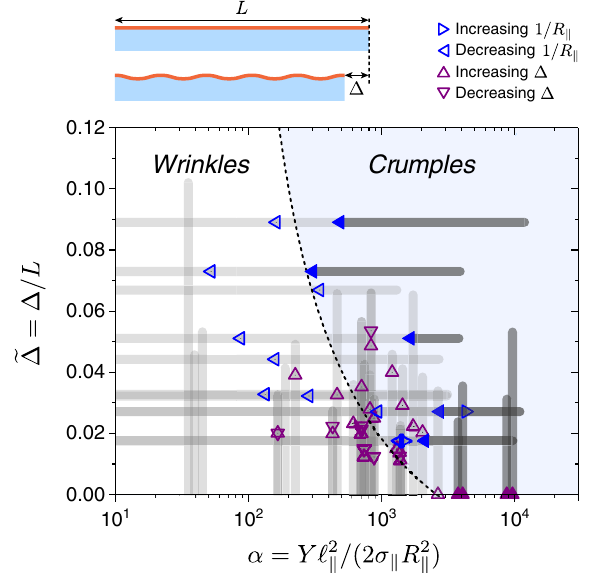
FIG. 7. Role of compression in the crumpling threshold. Symbols show the observed crumpling transition for experiments in the sheet-on-cylinder setup, where either the curvature 1 =R k or the compression Δ are varied while the other is held fixed. The sheet width ( 1 . 6 < W < 3 . 2 mm) and thickness ( 50 < t < 300 nm) are also varied, and γ ¼ 72 mN = m. Gray bands show the range probed in experiments. Over an intermediate range of α , wrinkles or crumples may both exist, depending on the com- pression. Filled symbols denote a transition to a morphology with crumples but no wrinkles, marked by the darker gray bands. ˜ Δ > 0 . 03 are also shown in Fig. (Open symbols with fixed